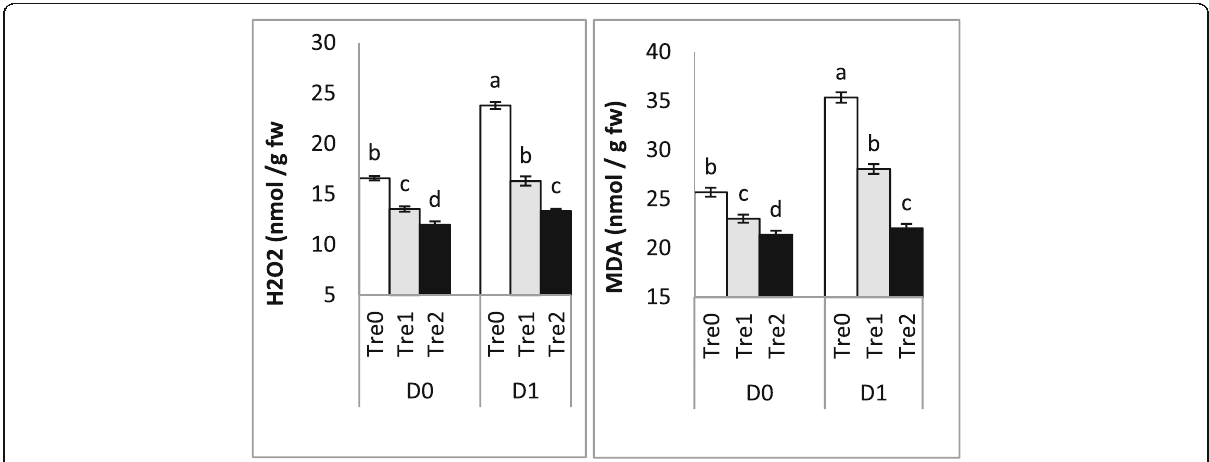
Fig. 3 Effect of trehalose (Tre1, 0.1 mM and Tre2, 0.5 mM) on H2O2, MDA contents (n mol/g fw) of quinoa plant under drought stress (at 75 days from sowing) Each value represents the mean ± standard error ( n = 3). Means with different letters above bars were significantly different at the 0.05 level according to Duncan ’ s multiple range